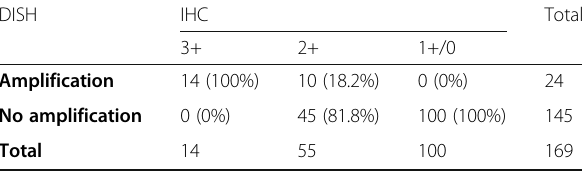
Table 3 Correlation between HER2 IHC expression and gene amplification in esophageal squamous cell